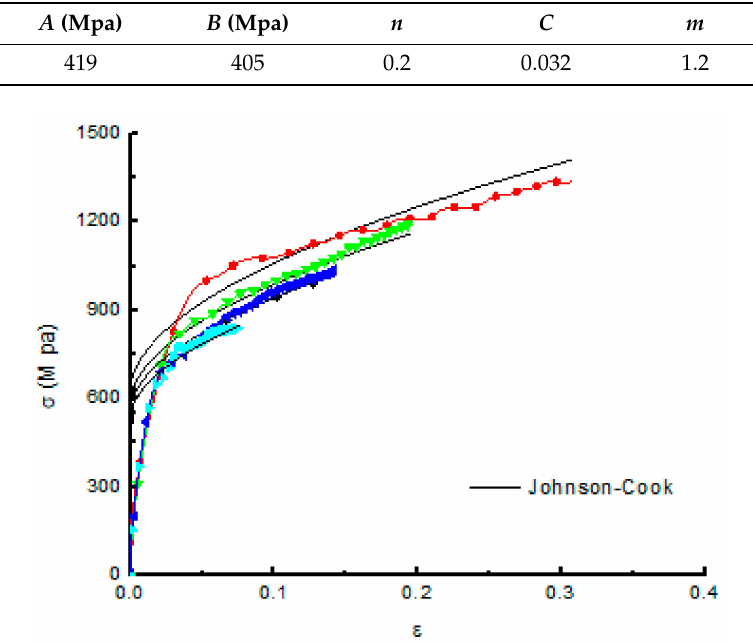
Figure 5. Comparison of Johnson–Cook model and the experiment data at 600 ◦